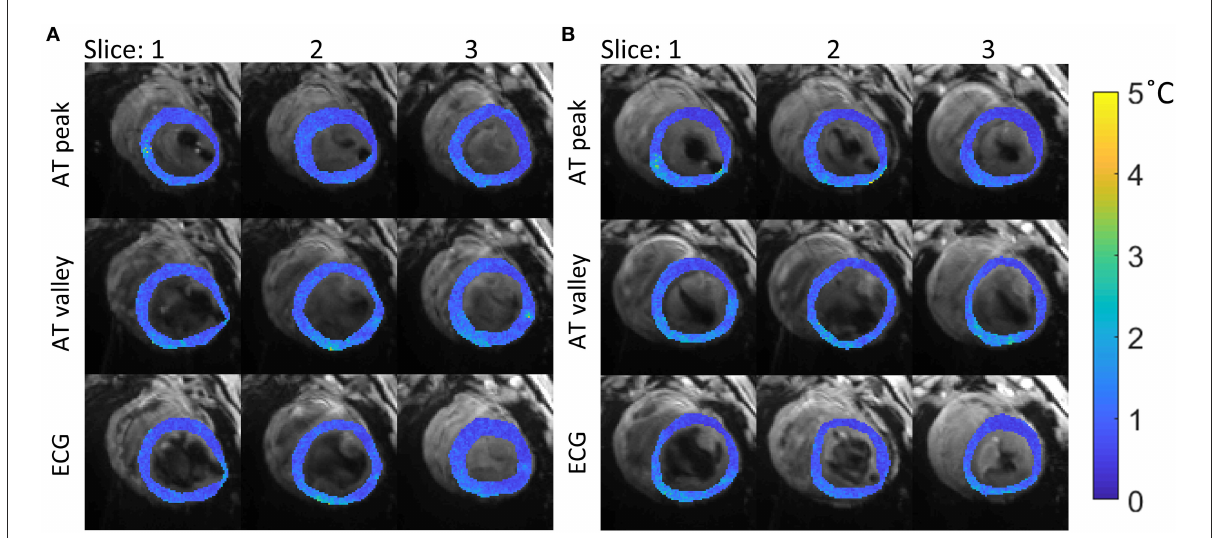
FIGURE7 Temperature stability maps of myocardial tissue acquired with the 3 different strategies for cardiac triggering. The stability values (colored maps) are overlaid on average magnitude images (gray scale). Data acquired in 2 different positions in the LV are shown: (A) position 4, mean ± sd per